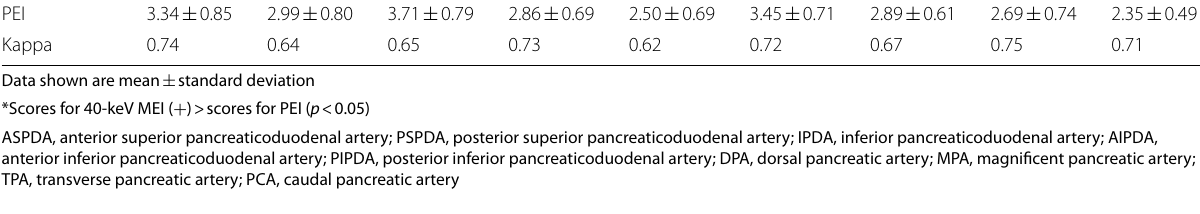
Table 3 The frequency of visualization of arteries